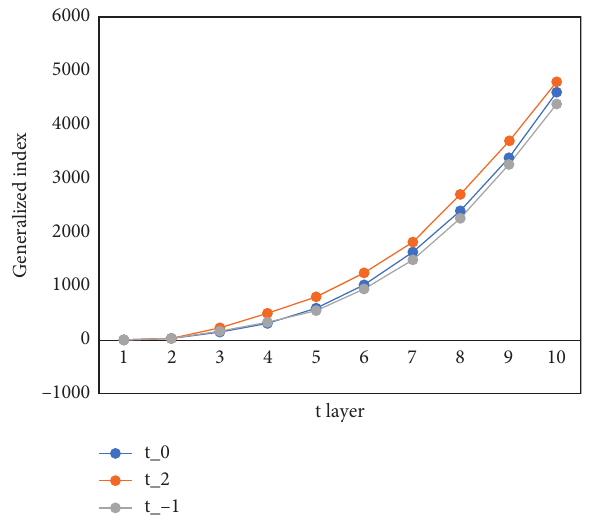
Figure 6: Numerical behavior of M c ( P